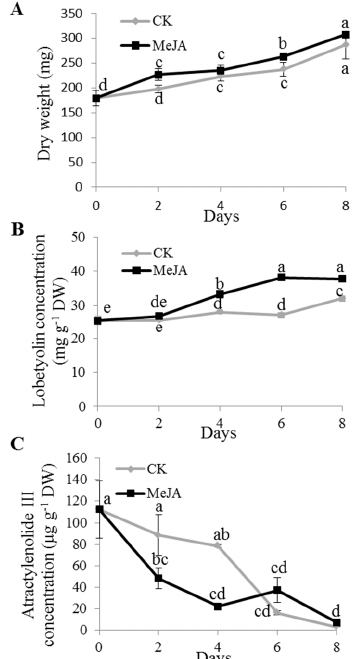
Figure 3. Dynamics of biomass ( A ), accumulation of lobetyolin ( B ), and atractylenolide III ( C ) in the adventitious roots of C. pilosula at 0, 2, 4, 6, 8 days after MeJA treatment. CK, blank control. Statistically significant differences between the means were determined using Fisher’s LSD test p < 0.05) and indicated with different lowercase letters.